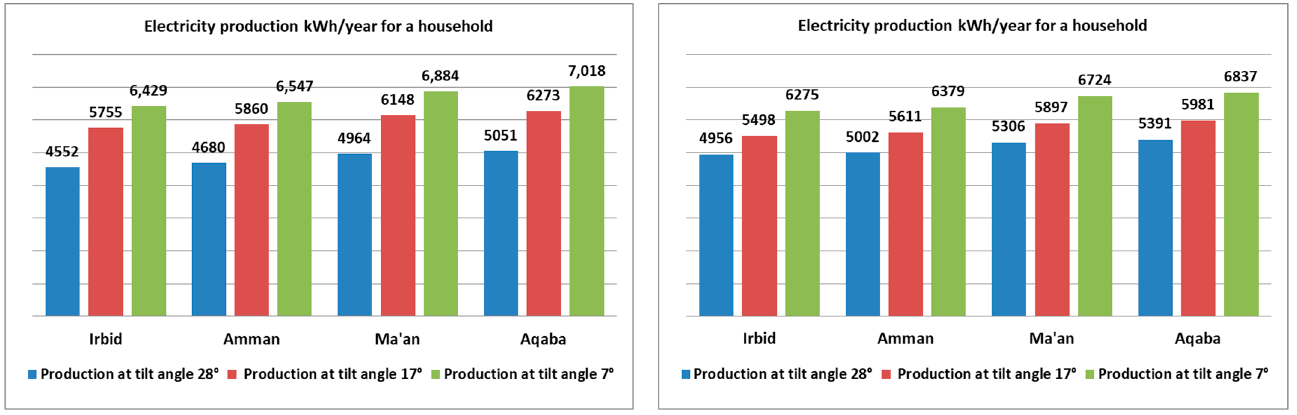
Figure 9. Electricity production for each household from the installation of PV systems on the rooftops of apartment buildings type ( a ) A1 and ( b ) A2.